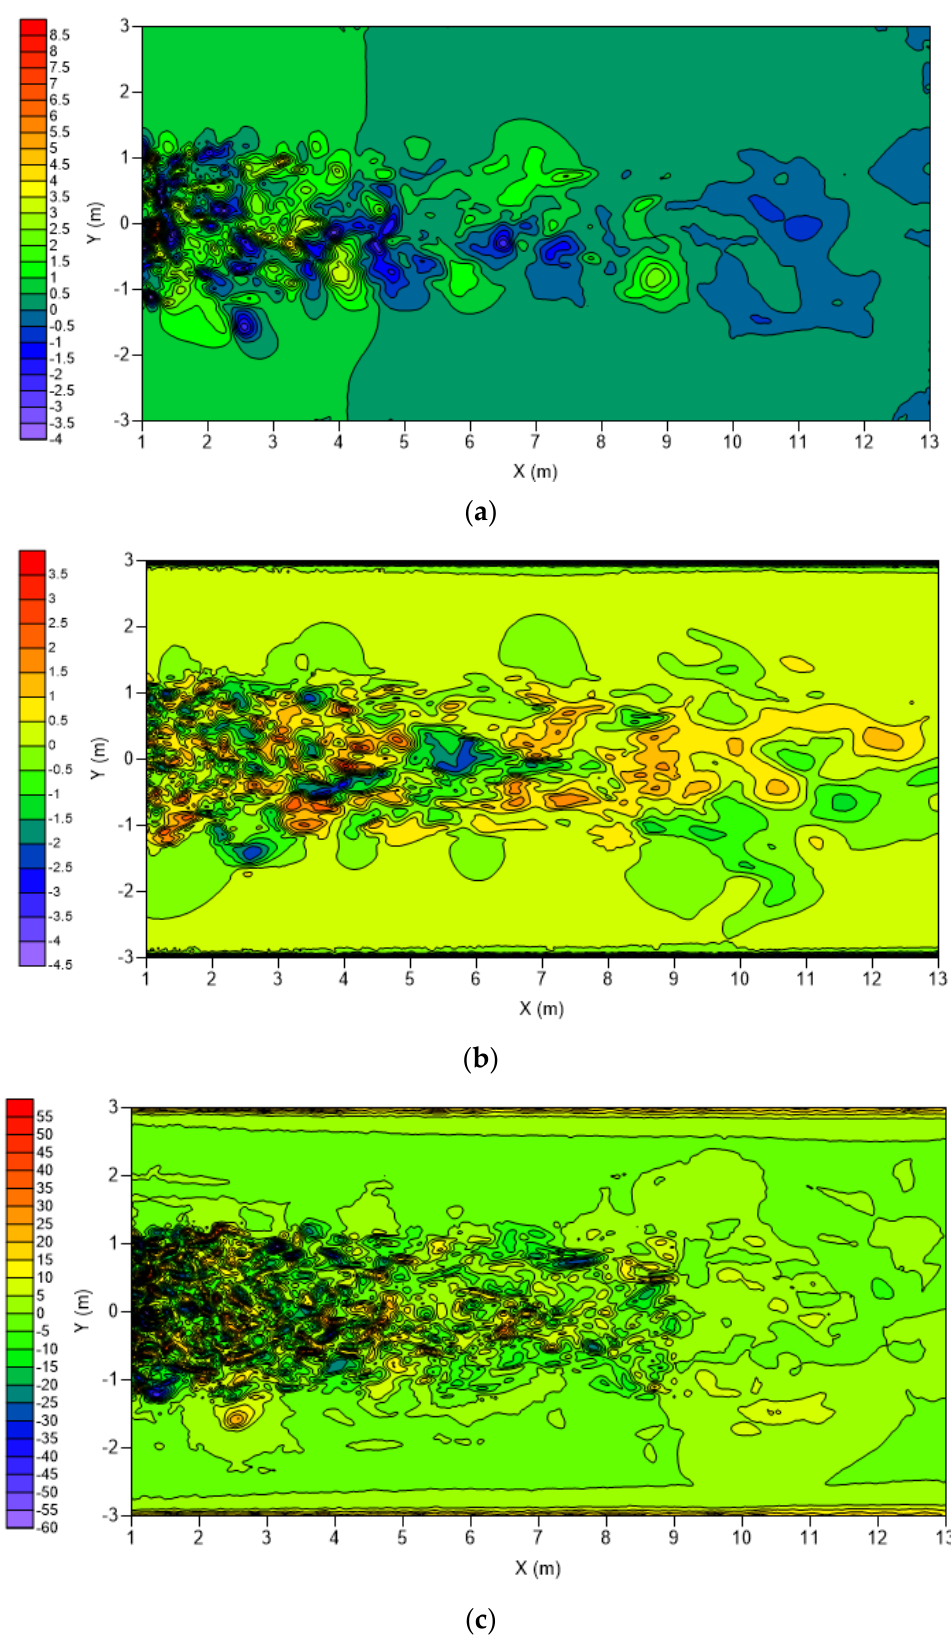
Figure 11. Spatial distribution of φ difference between the healthy and damaged VAWTs at 0° for ( a ) pressure, ( b ) velocity, and ( c ) vorticity